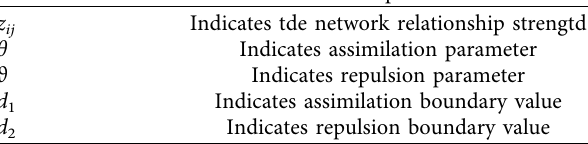
Table 2: Parameter